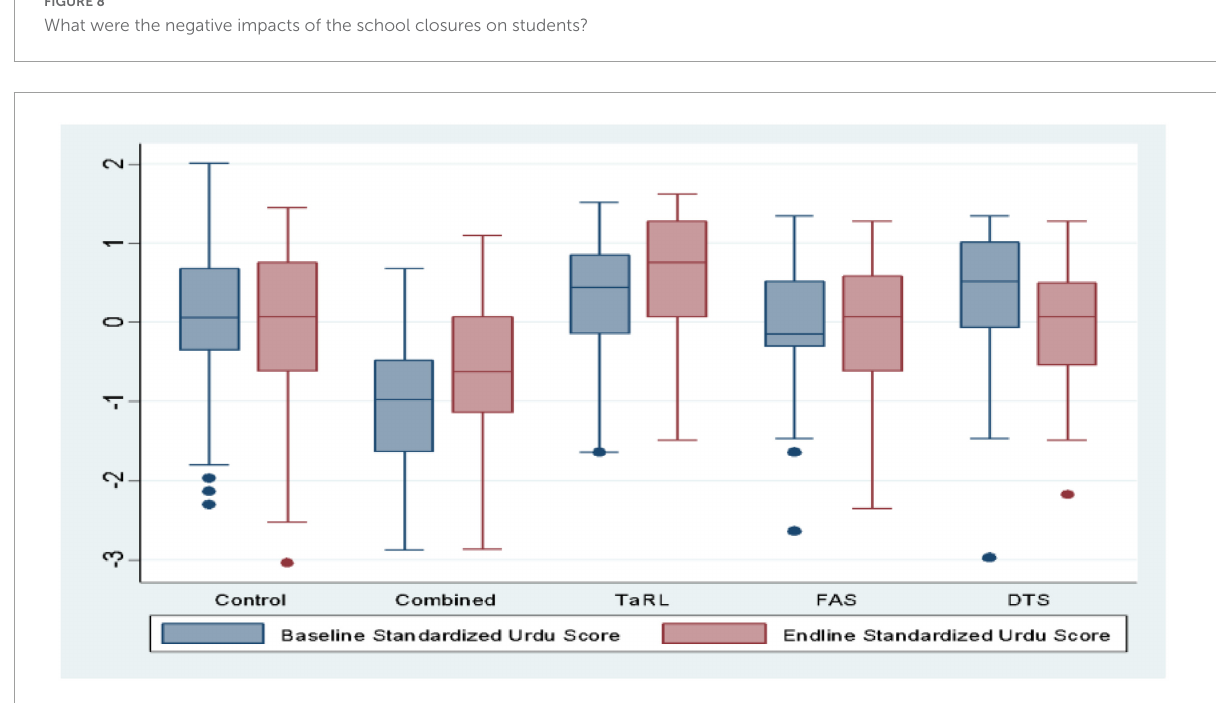
FIGURE9 Standardized Urdu scores before and after